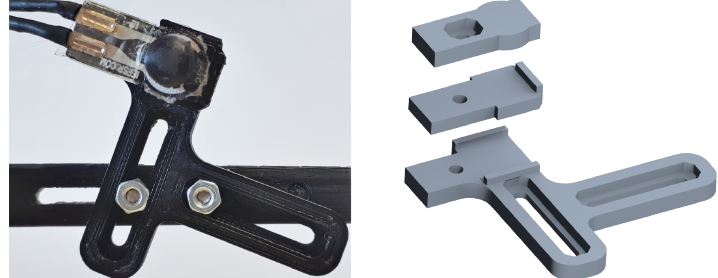
Figure 5. Image on the left shows the calibration system of the right temple in order to position the FSRs on the Temporalis muscle for mouse click activation. A dome-shaped plastic part is attached to the sensor to ensure good contact with the muscle. The right image shows an exploded view of the individual components to achieve the necessary